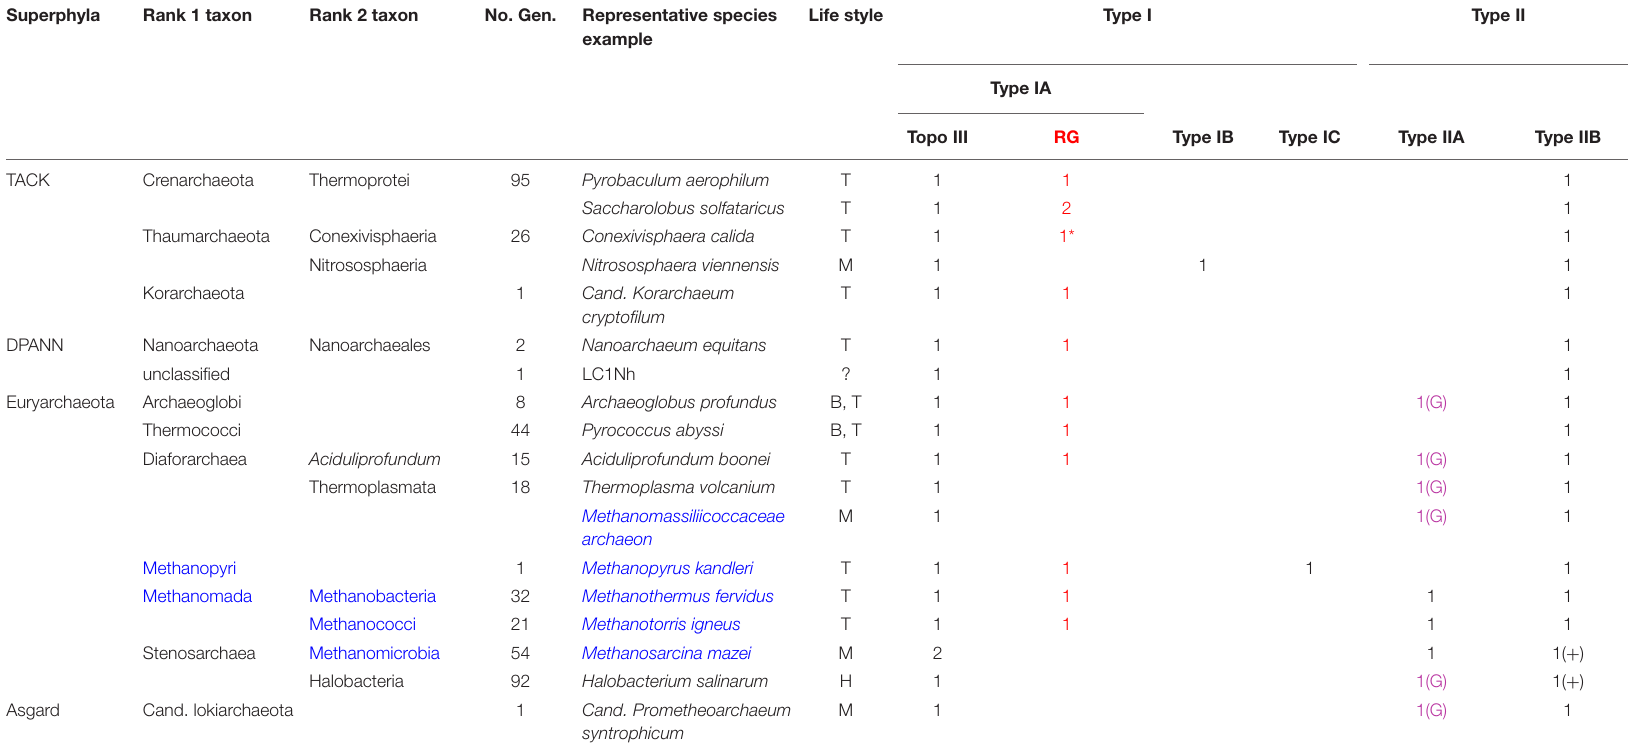
TABLE 1 | DNA-topoisomerases content in specific representatives of the different taxa in Archaea.